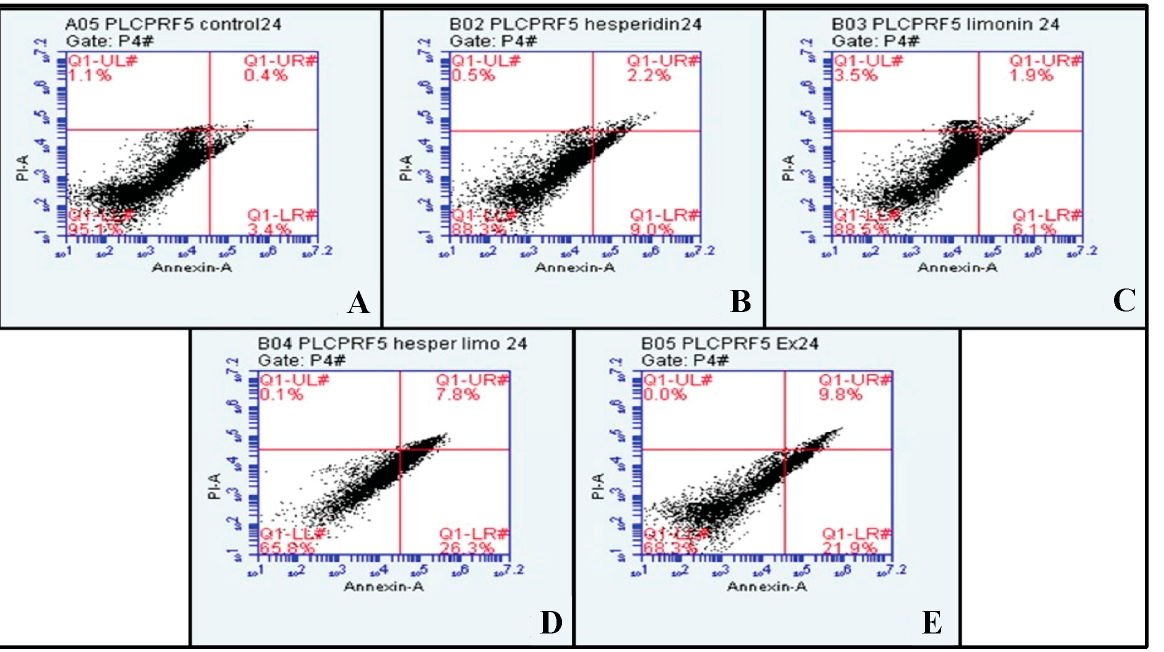
Figure 6. The dot plots of PLC/PRF/5 human hepatocellular carcinoma cells from flow cytometry analysis of Annexin V FITC/PI at 24 h in each treatment are ( A ) negative control (DMSO), ( B ) Hes- peridin at IC 50 , ( C ) Limonin at IC 50 , ( D ) Combination of Hesperidin and Limonin at IC 50 , and ( E ) lime peel ethanolic extract peel at IC 50 .